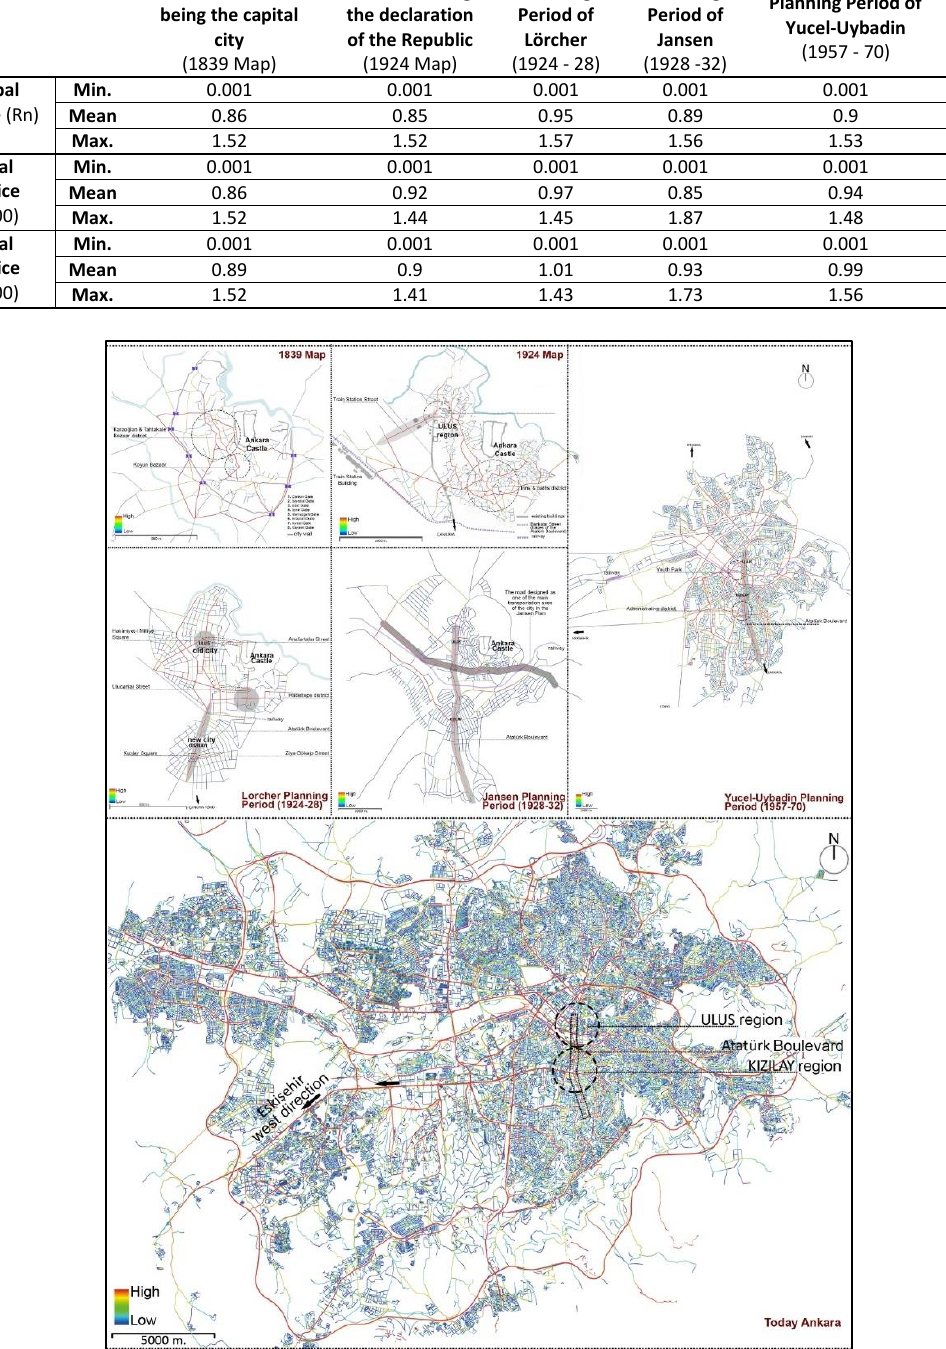
Figure 16 Global Choice (Rn)